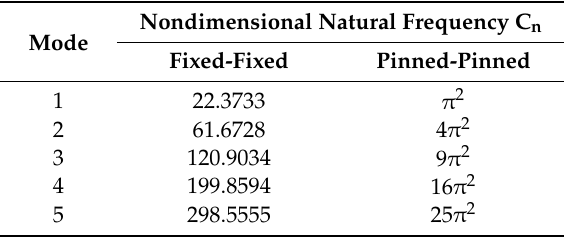
Table 1. Nondimensional natural frequencies dependent on boundary